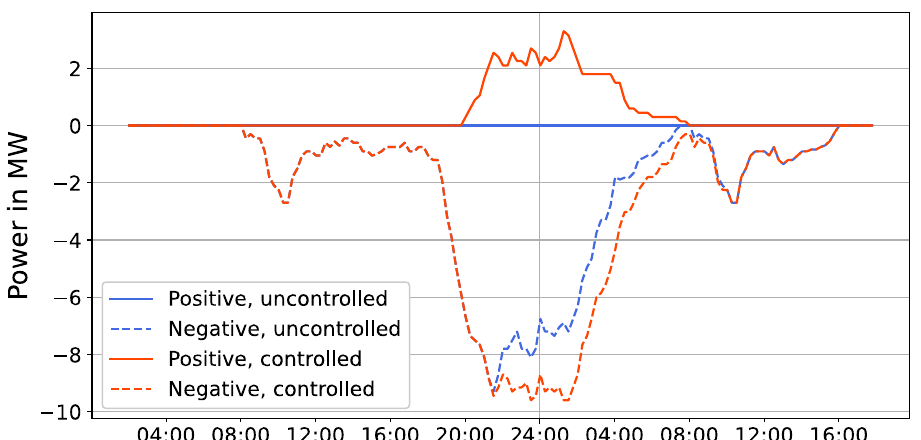
Figure 10. Currently available (instant) positive and negative power flexibility for the BD1 for a period of 36 h.